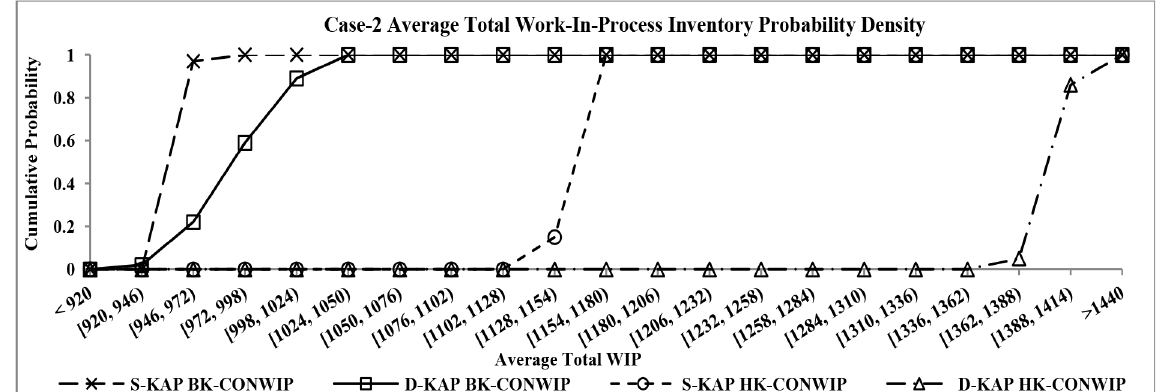
Figure 8. Case-2 cumulative distribution function plot of average total WIP